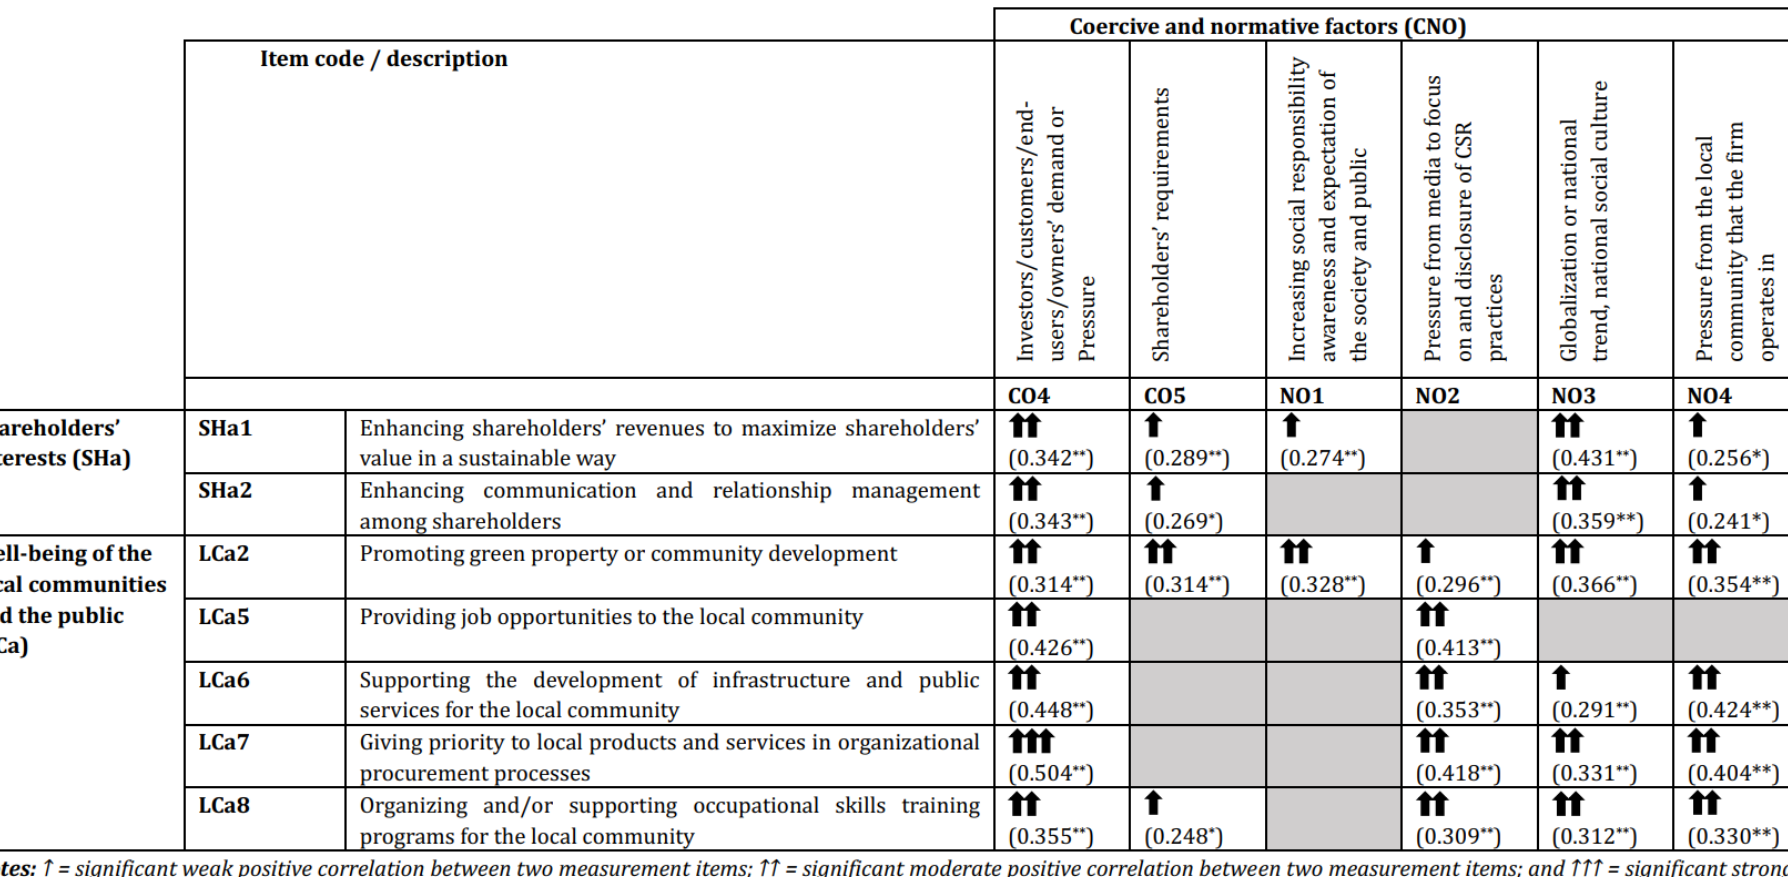
Figure 6. Relationship guide 3 for checklists of corporate social responsibility implementation.